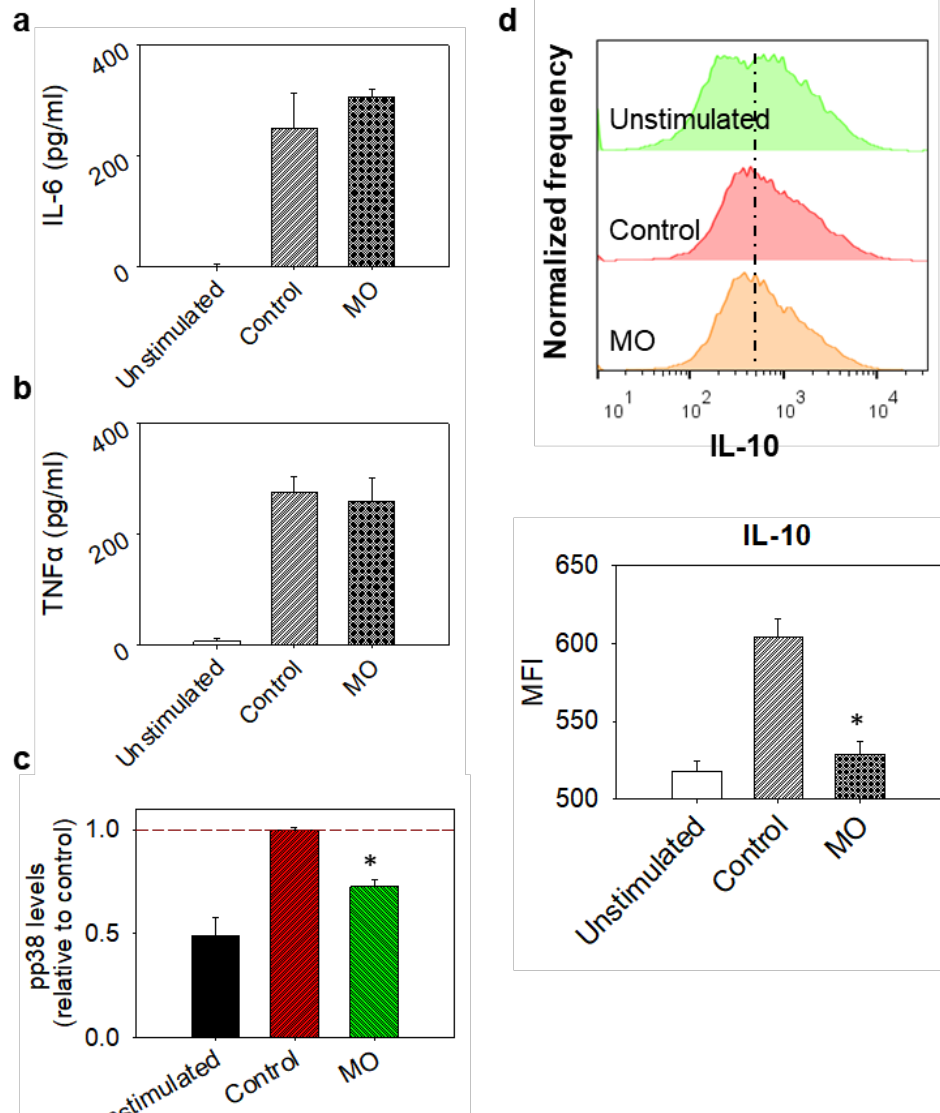
Figure 2. Ex vivo effects of MO in thioglycolate-elicited murine peritoneal macrophages. Cells were collected from the peritoneum of BALB/c mice, 4 days after i.p injection of thioglycolate and left to adhere on culture dishes. MO-treated macrophages were incubated with 8.9 µ g/mL MO for 30 min before the addition of 100 ng/mL LPS; control cells were incubated in LPS only, while unstimulated cells were grown in plain medium. Culture supernatants were collected 24 h later. ( a ) IL-6 and ( b ) TNF- α levels in macrophage culture supernatants analysed by ELISA. Bars represent cytokine levels. Data are presented as mean ± SD of at least three independent experiments. ( c ) Phospho-p38 (pp38) MAPK levels in cells, determined with the PathScan ® Inflammation Multi-Target Sandwich ELISA Kit. Bars represent pp38 levels expressed as a relative to control ratio. Dashed line indicates normalised control levels as reference. ( d ) Intracellular IL-10 detection in cells by flow cytometry. Bars represent intracellular IL-10 levels and data are presented as mean ± SD of at least seven ( n = 7) animals. MFI stands for median fluorescence intensity. Results are representative of at least three independent experiments. Asterisks indicate statistically significant difference compared to control (Student’s t -test, p ≤